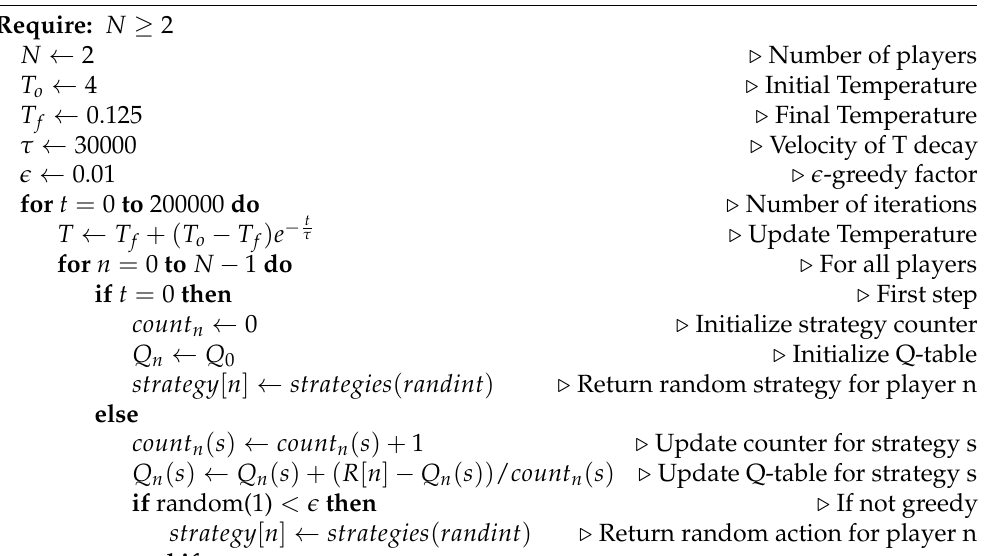
Algorithm 1 Agents learning mixed strategies in quantum games